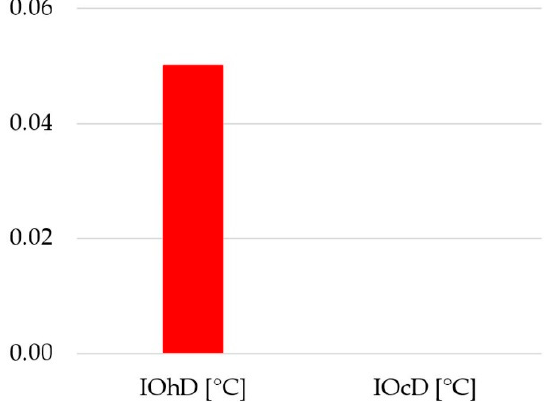
Figure 6. Building overheating value using 𝐼𝑂ℎ𝐷 and overcooling value using 𝐼𝑂𝑐𝐷 from May 2018 to April 2019.